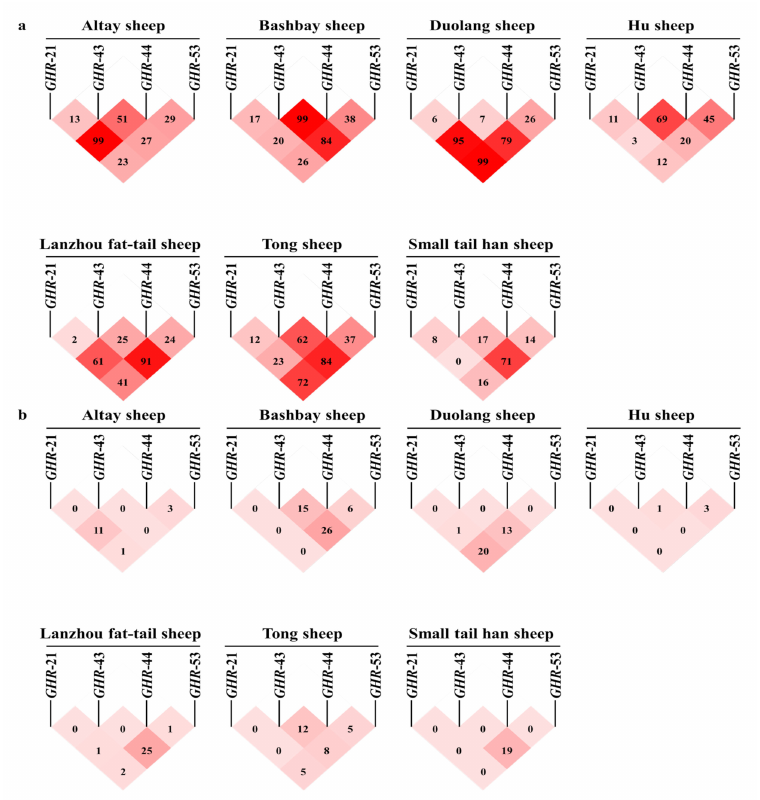
Figure 3. Linkage analysis of four variation sites of GHR in seven populations. ( a ) D’ analysis of seven sheep breeds in four GHR loci; ( b ) r2 analysis of seven sheep breeds in four GHR